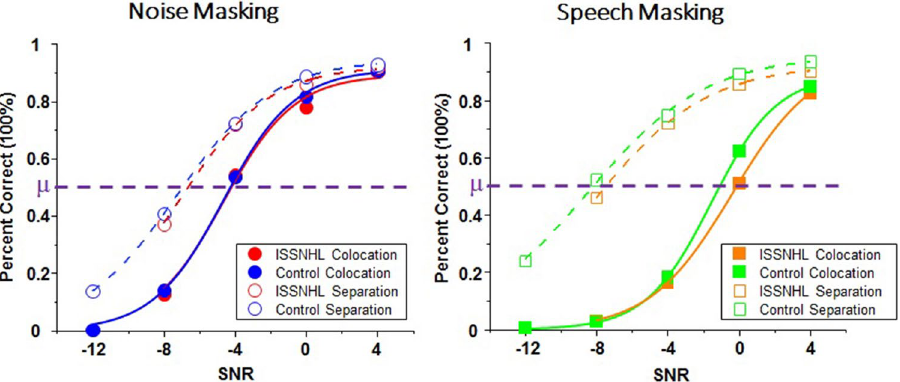
Figure 2. Group mean percent of correct as a function of signal-to-noise ratio (SNR) in noise masking condition (left panel) and speech masking condition (right